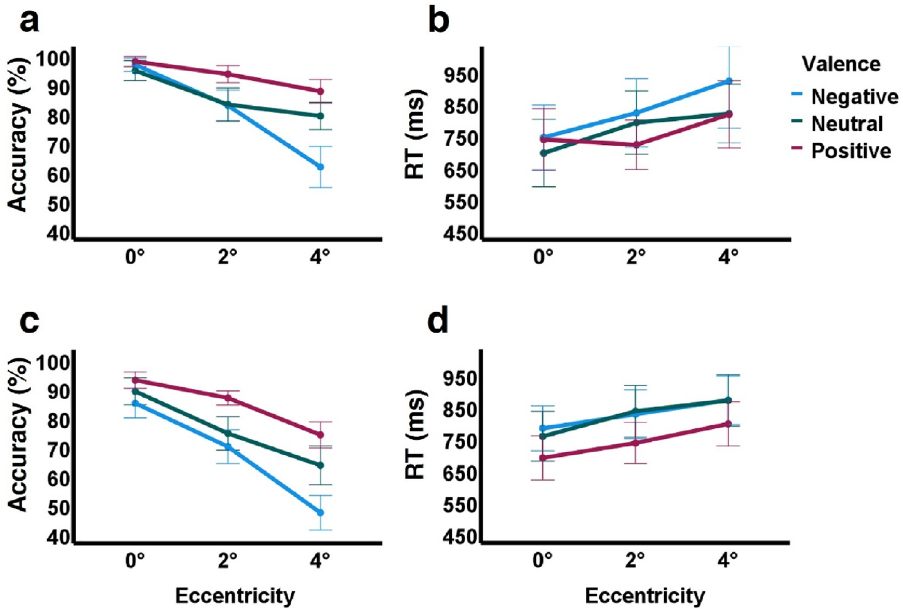
Figure 2. Accuracy and reaction time results for block-design (n = 51) and single-trial (n = 37) experiments. ( a ) Accuracy in block-design experiment (negative valence in blue, neutral in green, positive in red) significantly decreased with eccentricity, with stronger reduction for negative valence (evident by main effect of valence and an interaction between valence and eccentricity). ( b ) Reaction times (RTs) in the block-design experiment were significantly affected by eccentricity but not by valence. ( c , d ) Results for single-trial experiment reveal very similar effects on performance to those in the block-design experiment but with poorer average accuracy (see direct comparison in Fig. 3) with negative valence accuracy reaching chance level at 4°. A significant effect of valence on RTs was also observed with faster responses for positive valence. See “Results” section and Tables 1 and 2 for more details.